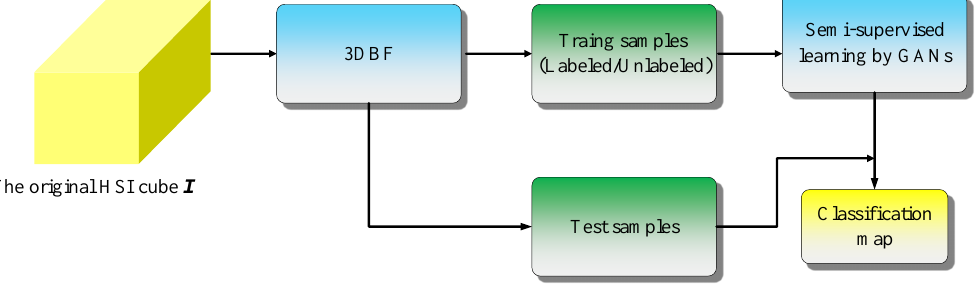
Figure 1. Flowchart of the proposed